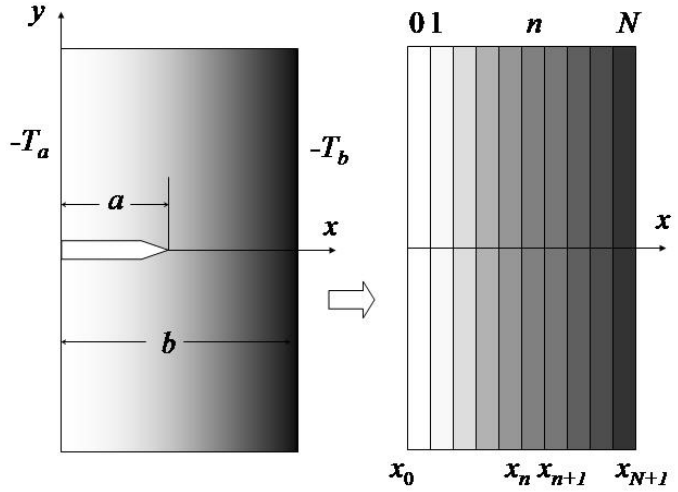
Figure 1. An FGM plate subjected to a thermal shock and a multi-layered material